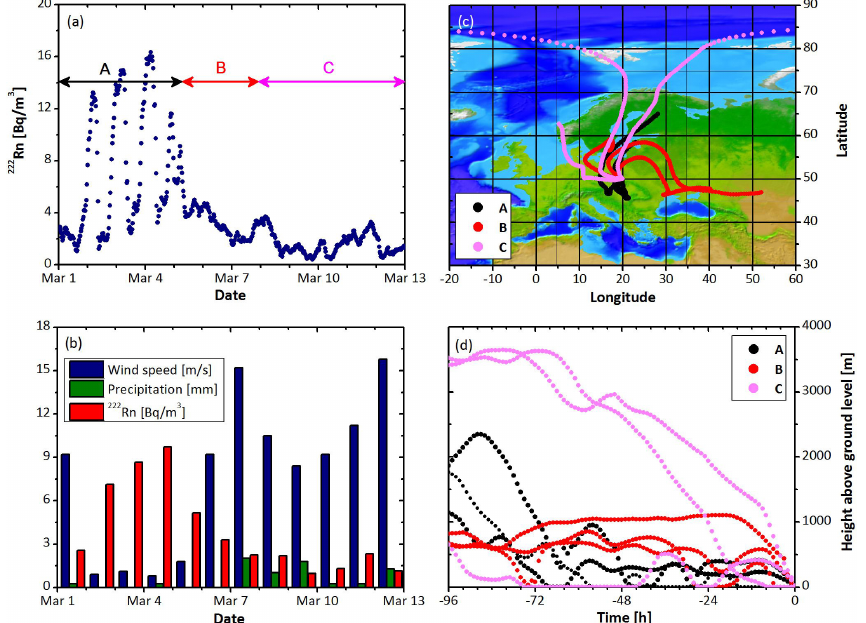
Figure 3. (a) Changes of atmospheric 222 Rn concentration in Krakow between 1 and 13 March, 2005. Horizontal lines with arrows and letter symbols mark different air masses identified in (c) . (b) Daily means of atmospheric 222 Rn concentration, wind speed and rainfall amount in Krakow. (c) 96h backward trajectories of the air masses arriving in Krakow, starting at 25, 50 and 75% of the time period A, B and C marked in (a) . (d) Changes of the elevation of trajectories shown in (c)